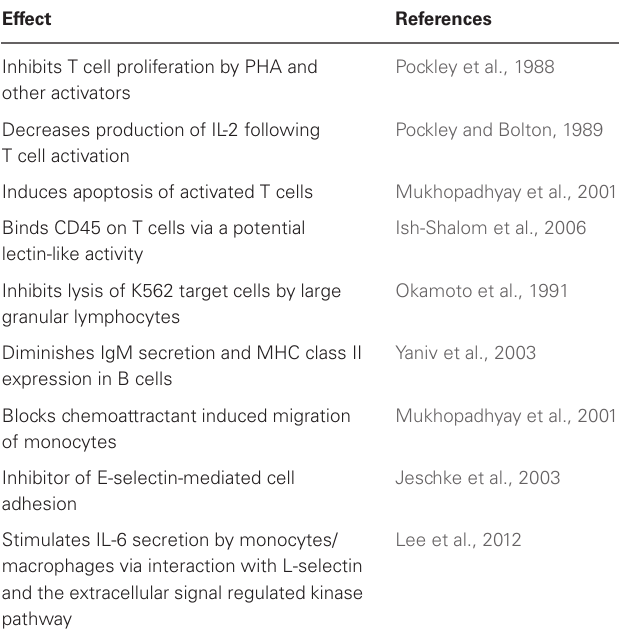
Table 1 | Immunomodulatory activities of